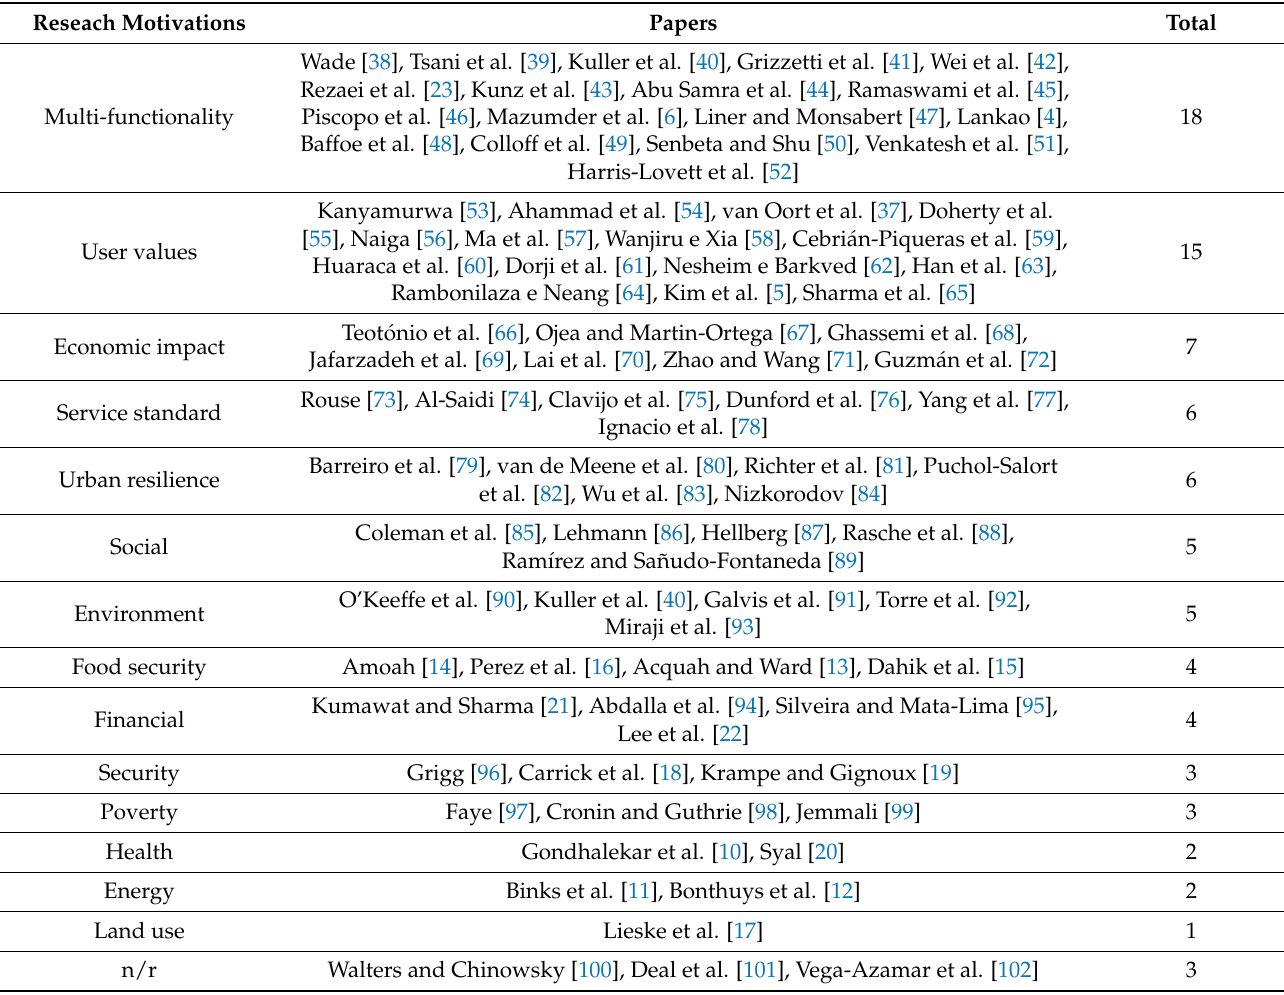
Table 2. Total of papers per research